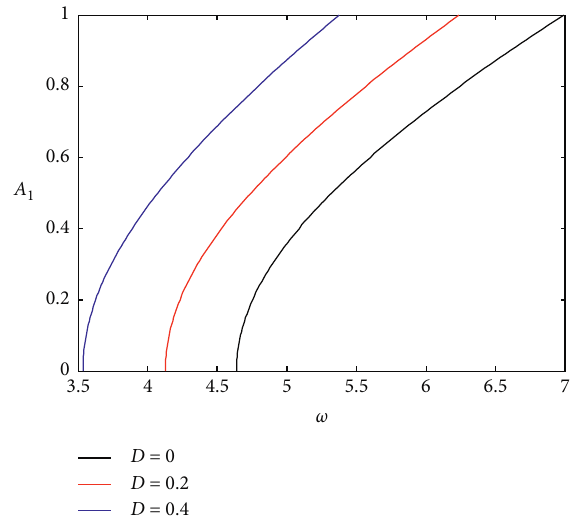
Figure 2: Damage effect on frequency-response curves of the microplate.